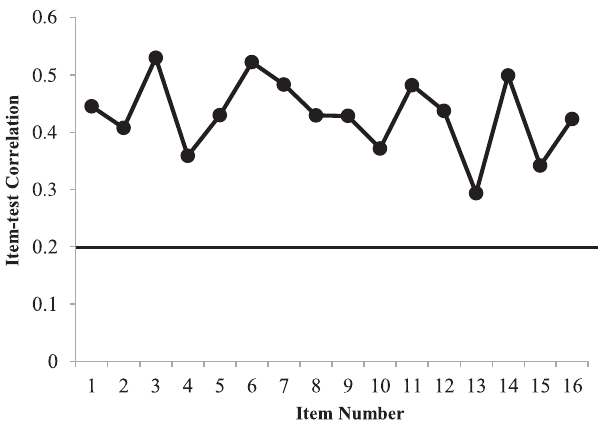
FIG. 4. Item-test correlations (as measured by Pearson ’ s r ) for each of the items on the CMR CUE. For N ¼ 421 , any correlation greater than 0.09 is significant at the p < 0 . 05 level [20]; thus, item-test correlations are statistically significant for all items. The conventional cutoff for an acceptable correlation (0.2) is marked as a bold